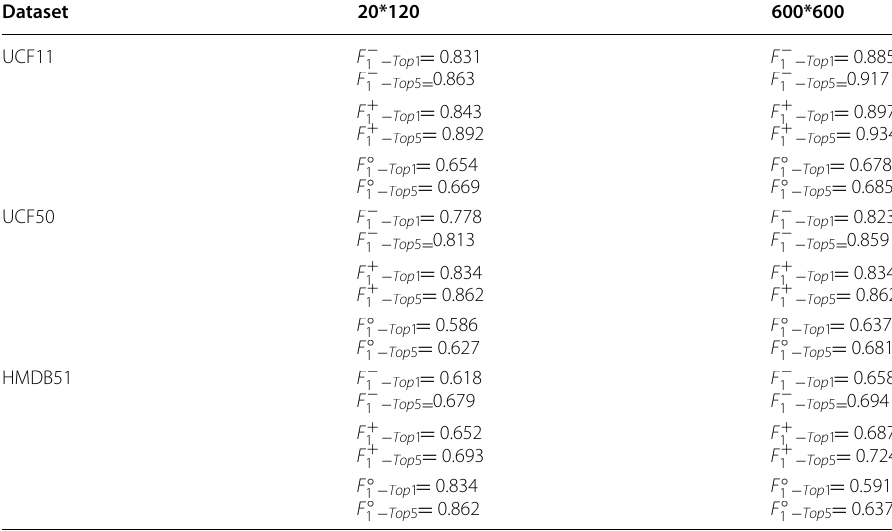
Table 6 F1‑Score performance of S ∗ , unchanged videos ( F − test 1), modified videos ( F + test 2), translated, rotated, scaled videos ( F ◦ test 3) using 10*10 block